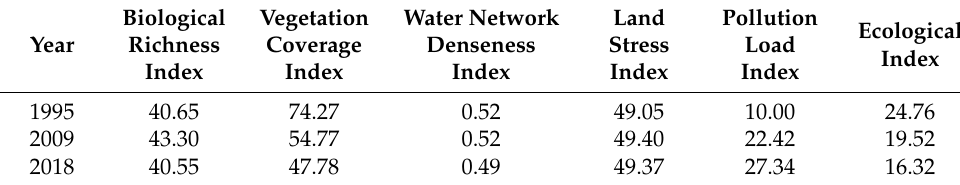
Table 10. Results of EI in Hetian.